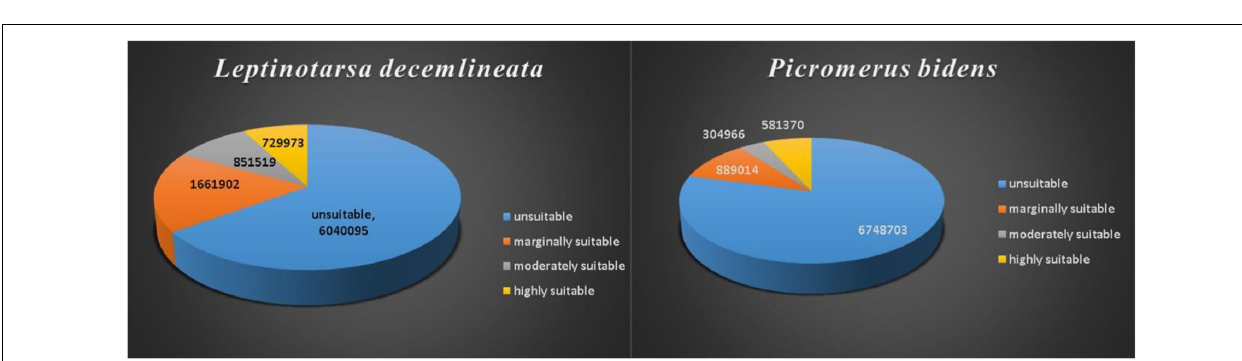
study area, respectively. The suitable habitat area of P. bidens